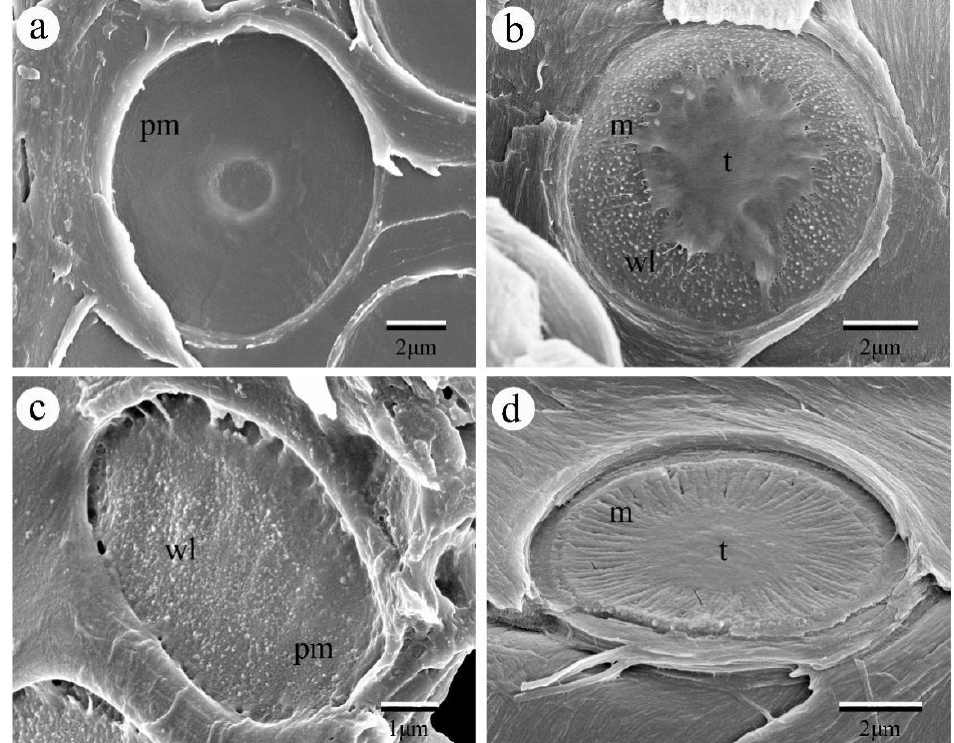
Figure 1. SEM images of pit membrane in between vessels of different angiosperm species and tracheids of gymnosperm species. ( a ) The pit membrane from Catalpa bungei C. A. Mey. showing very smooth surface with pit aperture visible through the pit membrane. ( b ) The pit membrane of Cedrus deodara (Roxb.) G. Don., showing scalloped torus margins and abundant warty layers inside the pit chamber. ( c ) The pit membrane from the vessel of Salix matsudana var. pseudo-matsudana , showing granular surface with many warty layers. ( d ) The pit membrane of Cephalotaxus sinensis , demonstrating extremely thick margo. Pm, pit membrane; m, margo; t. torus; wl. warty layer.